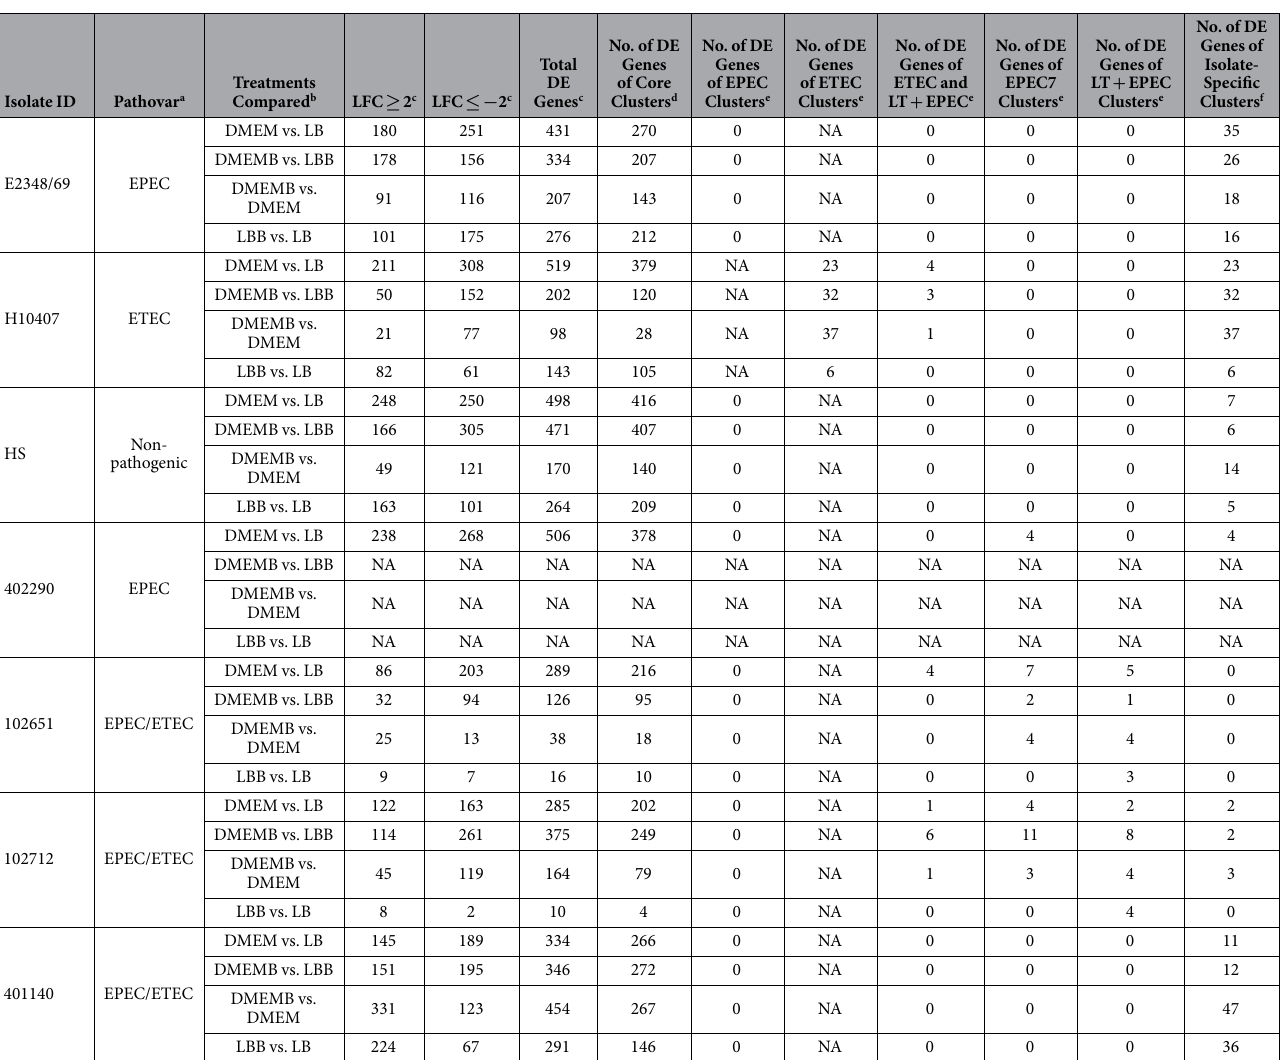
Table 3. Differential expression of conserved and unique genes in each of the E. coli isolates examined using RNA-Seq. a The pathovar designation based on virulence gene content. b The RNA-Seq samples compared by DESeq analysis. c LFC is the Log 2 fold-change of the genes that exhibited significant (LFC ≥ 2 or ≤− 2 and FDR ≤ 0.05) differential expression (DE). d The total number of core gene clusters (LS-BSR ≥ 0.8 in all genomes analyzed by RNA-Seq) is 3,559. e The number of DE genes that were identified by LS-BSR analysis as present (LS-BSR ≥ 0.8) in all genomes of the described group and absent (LS-BSR < 0.4) from all other genomes. f The isolate-specific genes are those that were in one genome with an LS-BSR value ≥ 0.8 and < 0.4 in the other